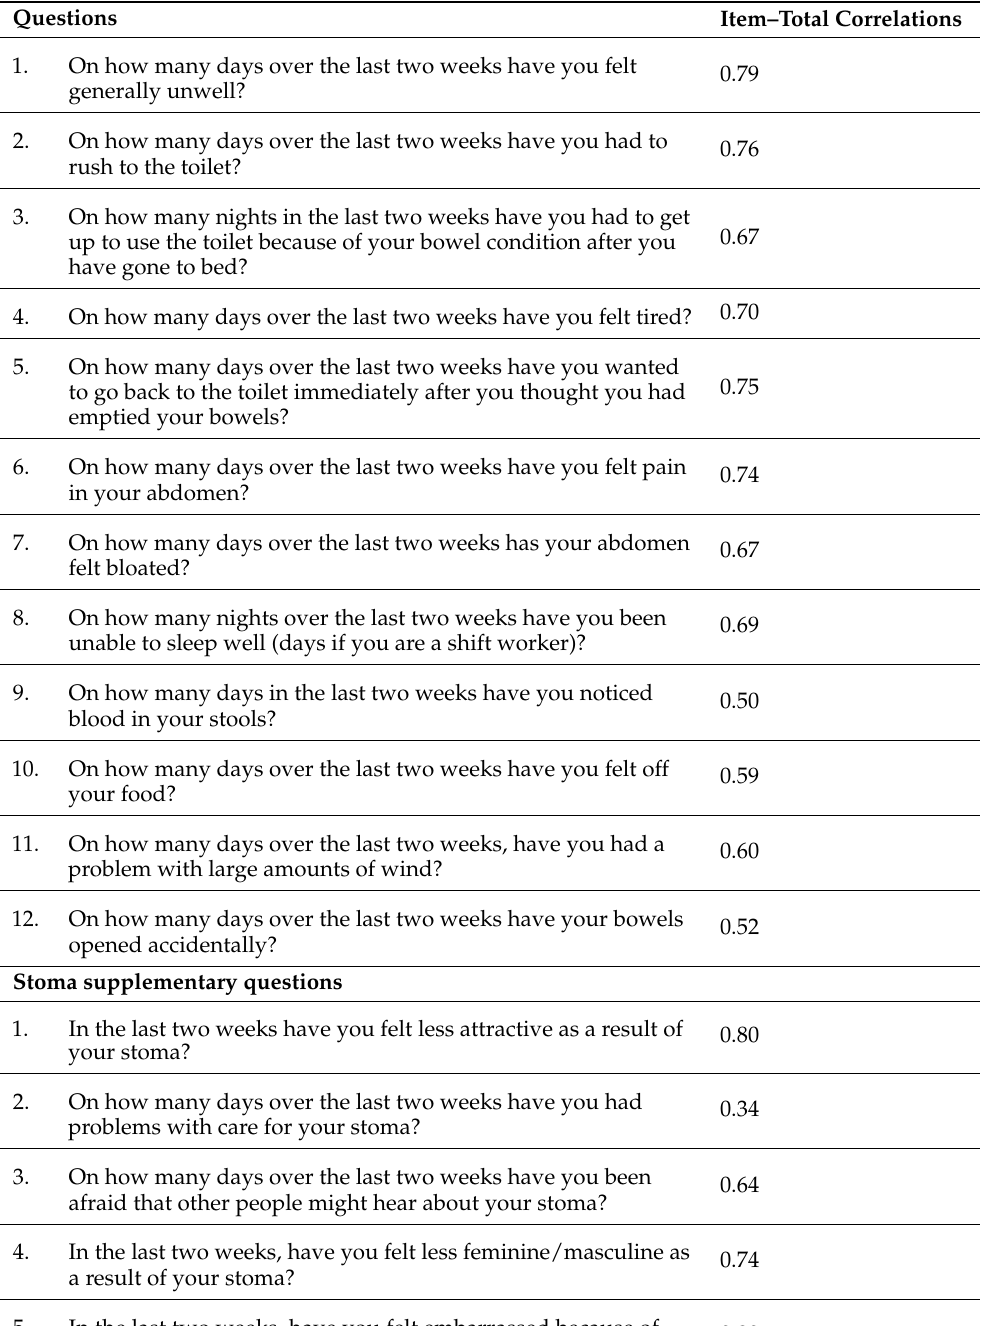
Table 4. Item total correlations for all the 12 items in